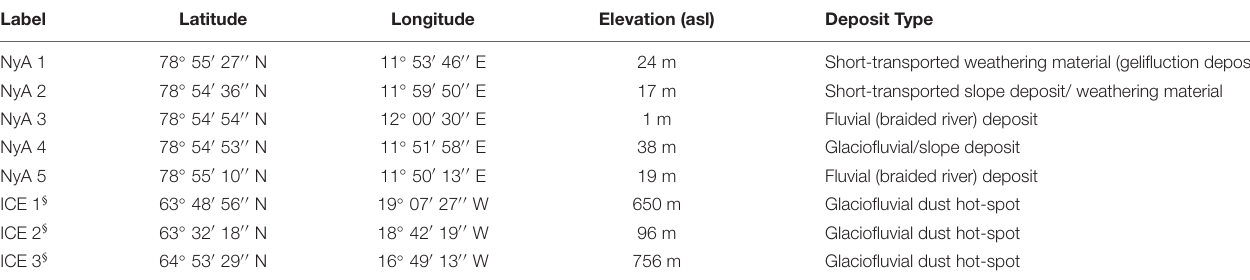
TABLE 1 | Location of sediment sampling sites by Ny-Ålesund (NyA) and in Iceland